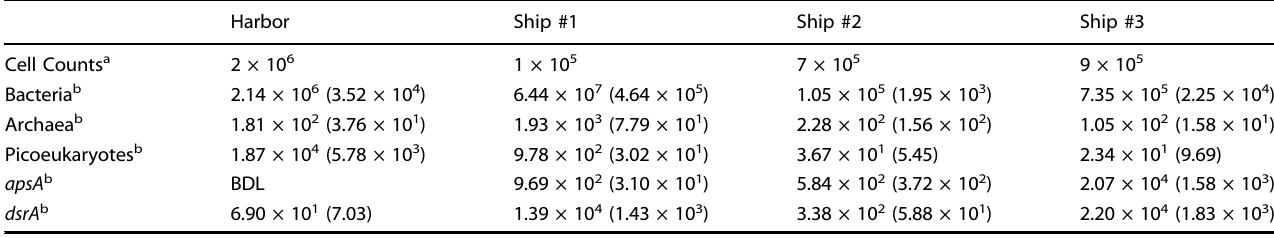
Table 2. Marine microbial population estimates and functional gene qPCR enumeration a